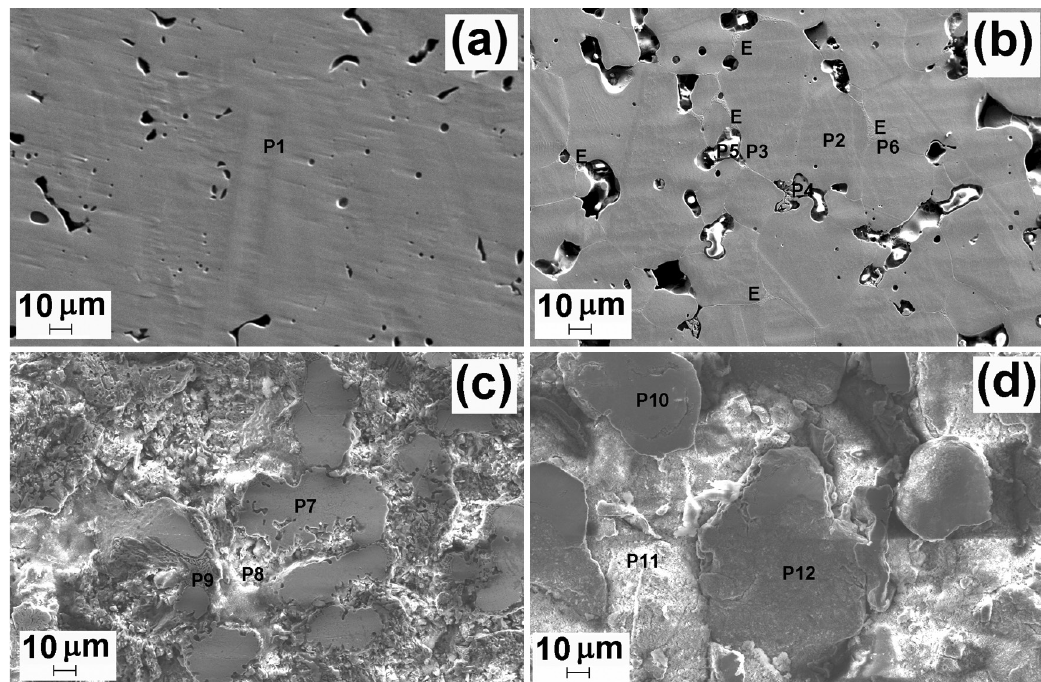
Figure 1. Microstructure of sintered (a) 316L stainless steel, (b) 5% HA‑316L, (c) 20% HA‑316L and (d) 50% HA‑316L